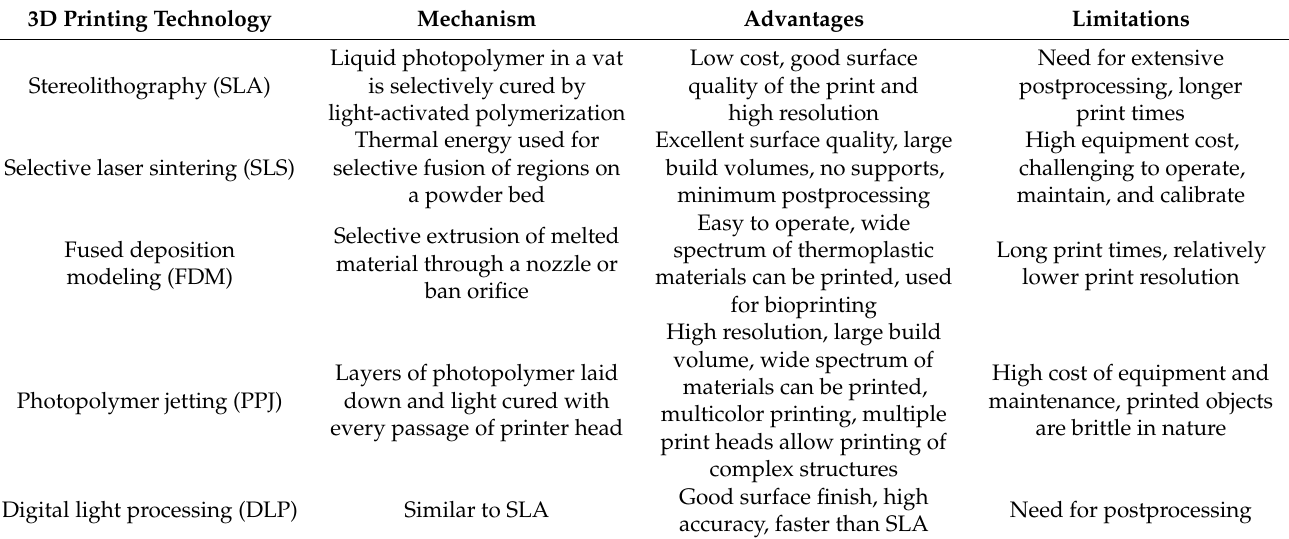
Table 1. Summary of 3D printing